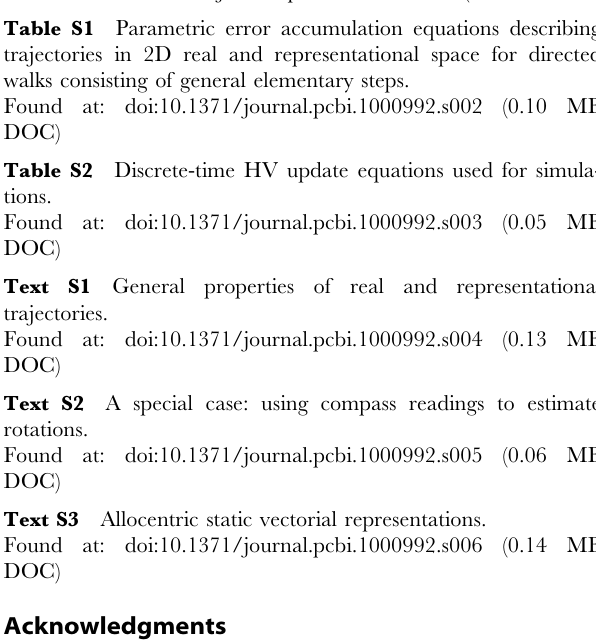
Figure S1 Stepwise geometric constructions of cumulative errors in representational space during path integration (PI).(A) In an allocentric framework, using an allocentric polar (AP) representa- tion of space during PI results in an accumulation of some amount of update error, e , during each step. Both clockwise (CW) and counterclockwise (CCW) update errors are illustrated. (B) In an egocentric framework, using an egocentric Cartesian (EC) representation of space during PI results in an accumulation of some amount of input error, d , during each step. An angular error ( 2 d ) in the compass (sun symbol) reading gives rise to an inferred rotation (input to PI system) in the opposite direction ( d ), which results in a home vector shifted by 2 d in representational space. The thick arrows denote forward, leftward and rightward. (C) In an egocentric framework, using an egocentric polar (EP) representation of space during PI results in an accumulation of some amount of update error, e , in addition to some amount of input error, d , during each step. Note that the sign of the update error, e , is independent of the spatial framework used (e.g., a CW rotation is CW in both egocentric and allocentric reference frames). Table S1 Parametric error accumulation equations describing trajectories in 2D real and representational space for directed walks consisting of general elementary steps.